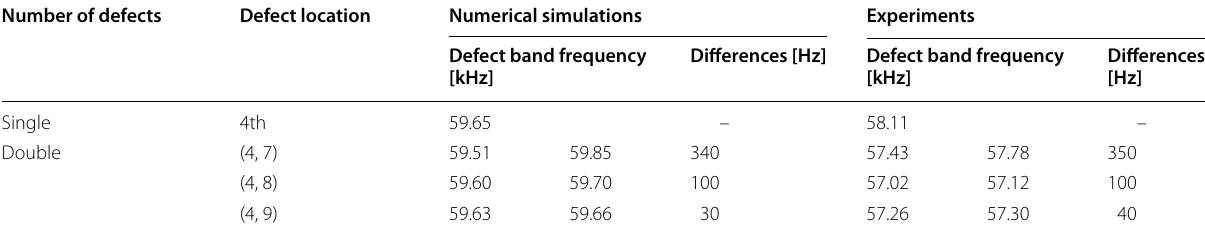
Table 1 Effects of the distance between the double defects on the defect band splitting along with its comparison with the